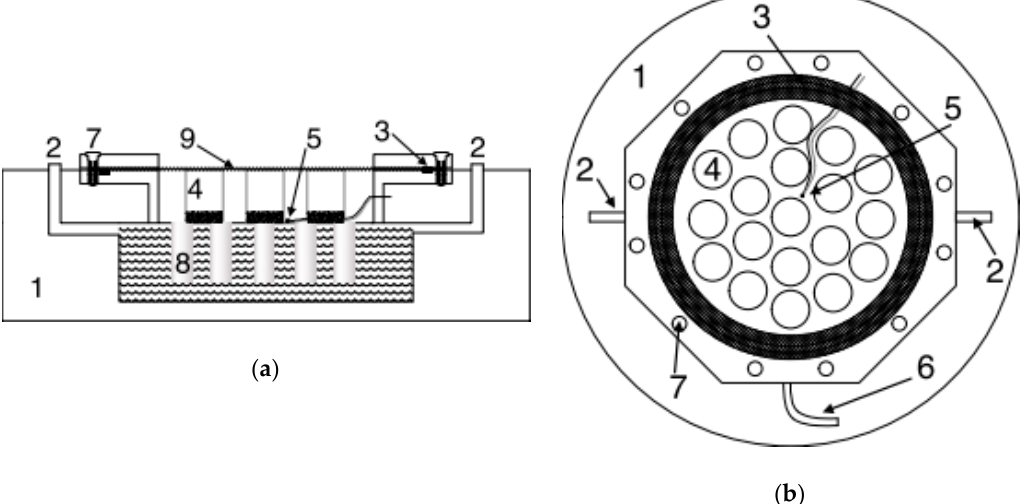
Figure 1. Scheme of the experimental chamber: ( a ) side view; ( b ) top view. 1—Thermoisolated cylinder, 2—tubes for liquid nitrogen filling, 3—vacuum rubber seal, 4—metallic cylinders supporting the Al foil, 5—thermocouple, 6—tube for vacuum pumping, 7—metallic ring with bolts for vacuum seal, 8—copper “cold fingers”, 9—Al foil with thickness 100 µm.